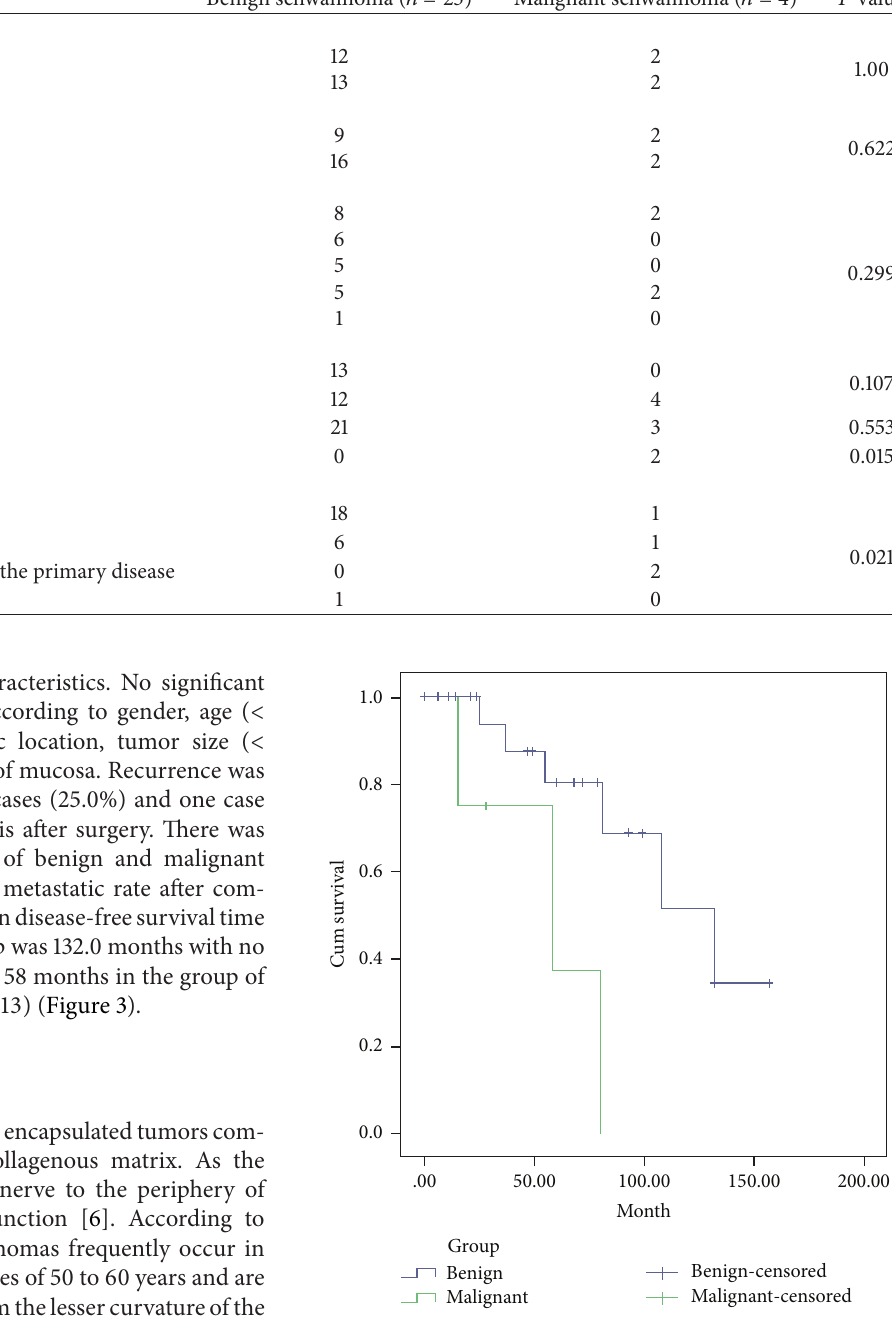
Figure 3: Cumulative survival of patients for the group of benign schwannoma and malignant schwannoma. ( 𝑃 = 0.013 ) for compar- ison between two